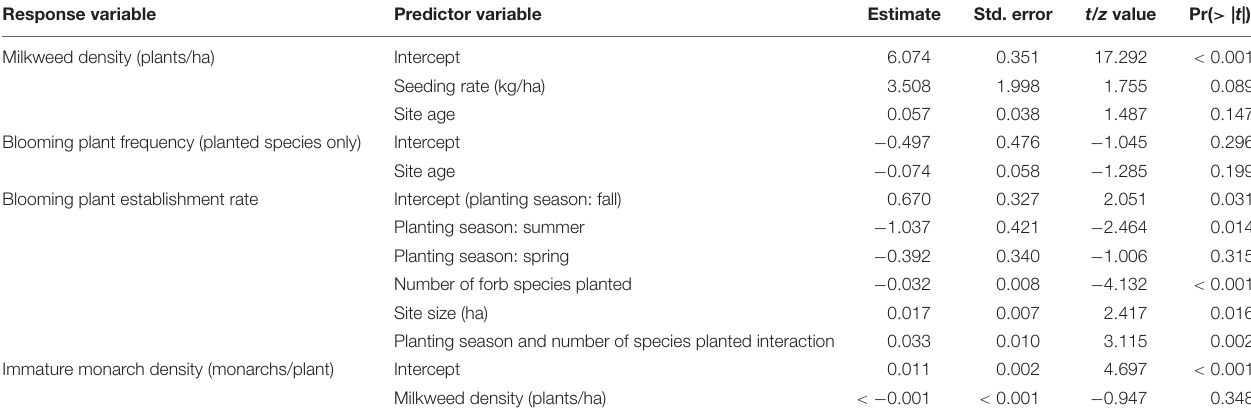
TABLE 4 | Model selection results for milkweed density, blooming plant establishment rate, blooming plant frequency, and immature monarch density. Response variable Predictor